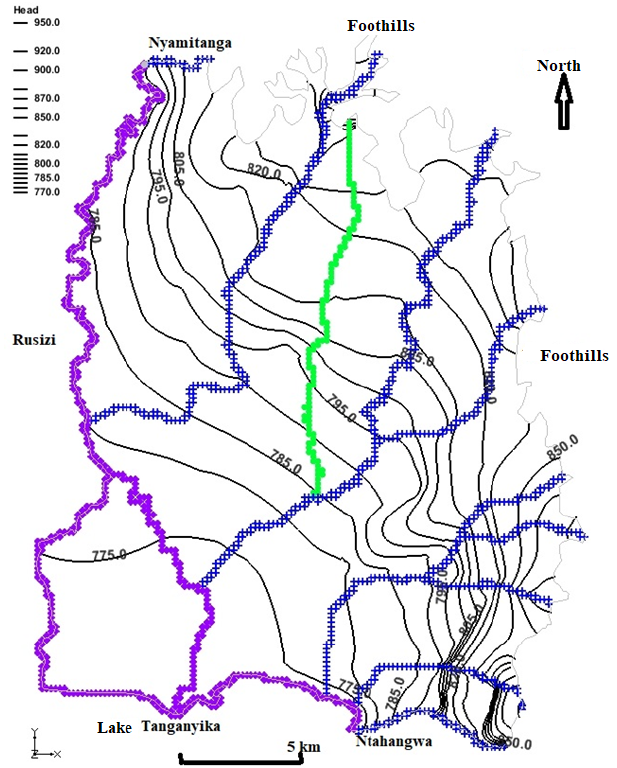
Figure 10. Computed piezometric map.